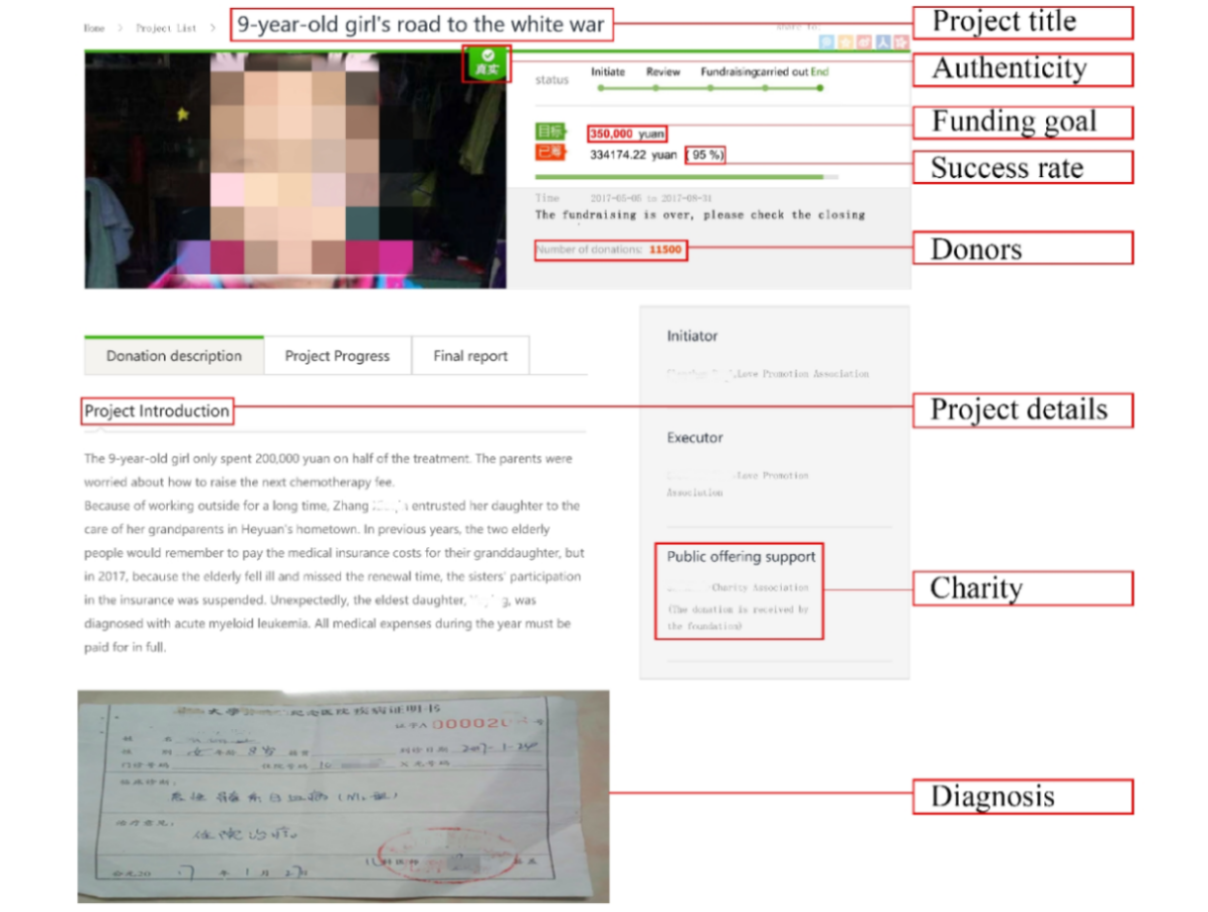
Figure 1. Screenshot of a medical crowdfunding